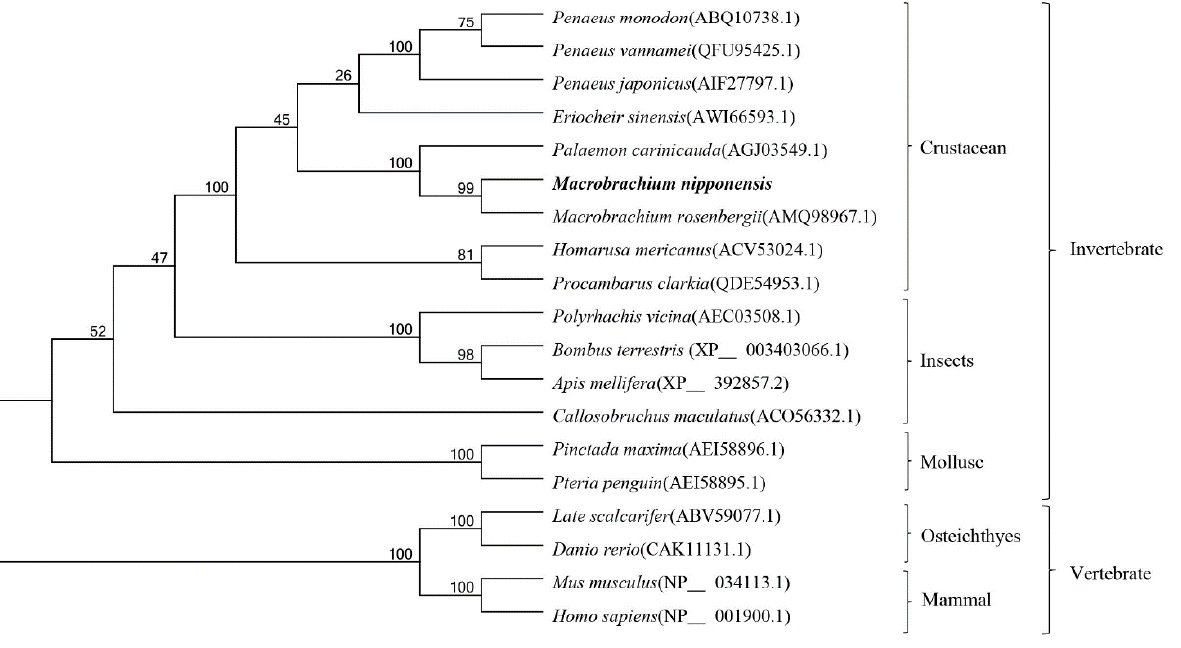
Figure 3. Phylogenetic tree of Mn-CTSD . The graph was generated by the MEGA5.0 program using the adjacency method. Bootstrap copy to 1000. The GenBank login number is in square